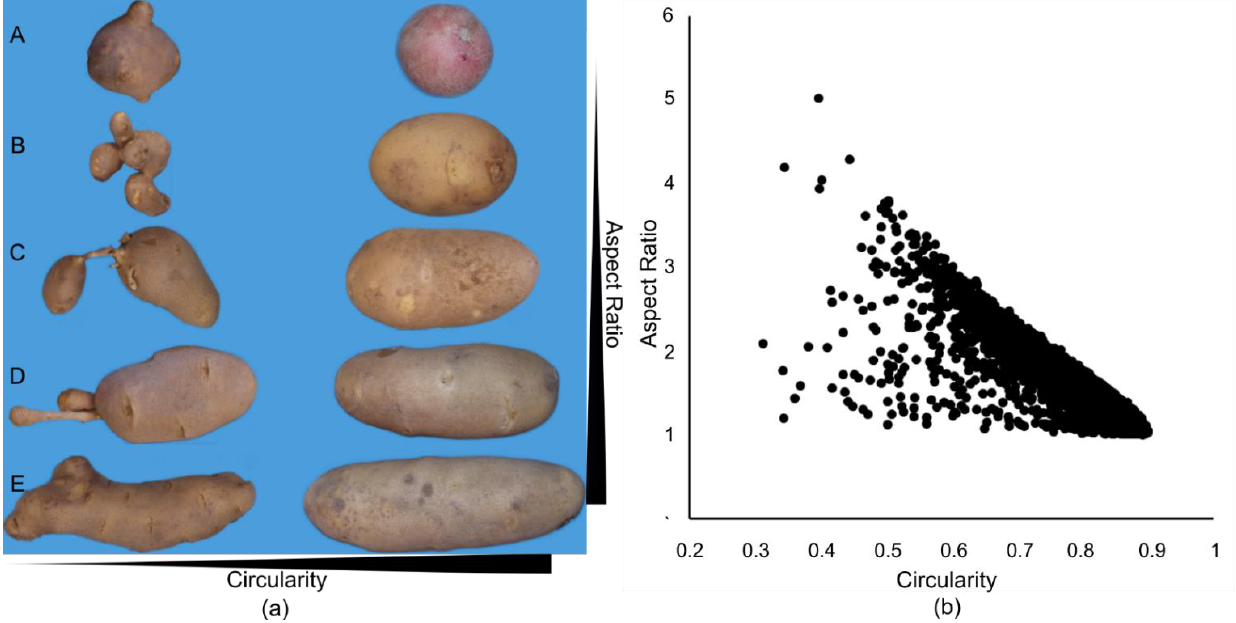
Figure 1. Tuber area vs. weight. Tuber area was calculated using ImageJ and compared to tuber weight. ( a ) individual tuber weight vs. area. ( b ) prediction model for tubers harvested from a single plant grown in the greenhouse. Dashed lines indicate 95% prediction interval.